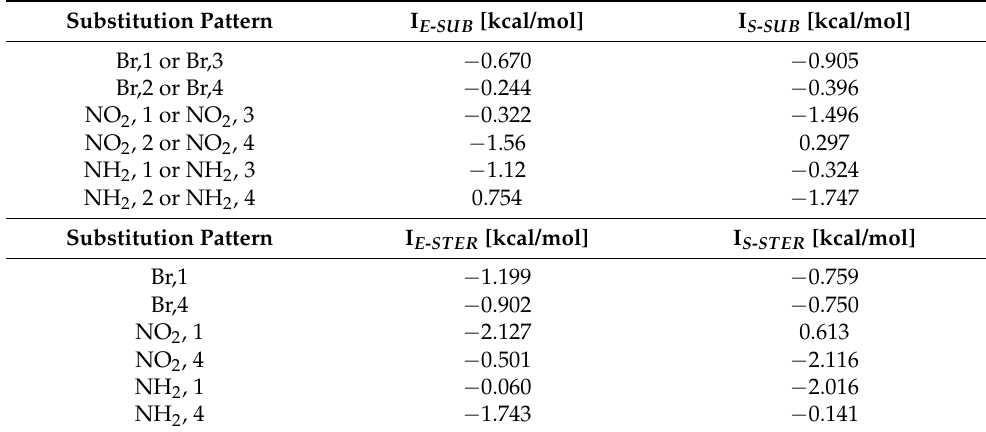
Table 3. Empirical values of increments for the activation energy and the second minimum in the proton transfer process, calculated on the basis of para and meta groups.